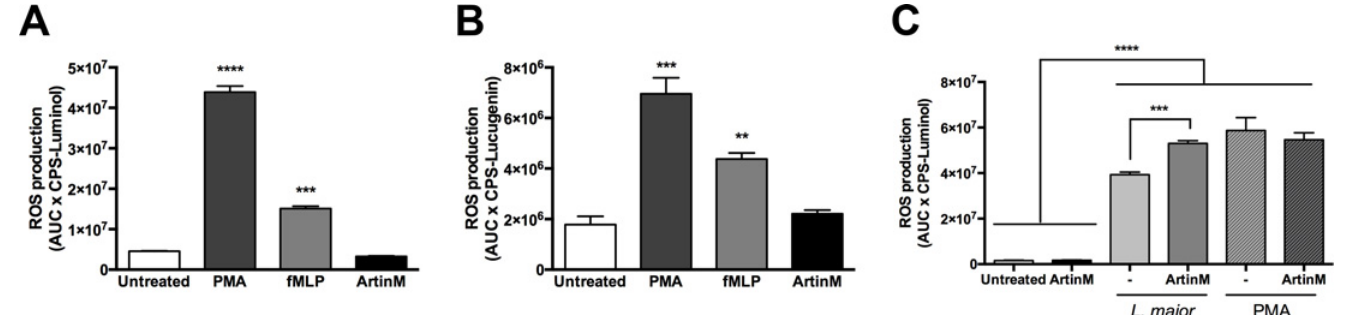
Fig 5. ArtinM augments ROS production by L . major -infected neutrophils. Human neutrophils were treated with PMA, fMLP, ArtinM or medium (untreated). ROS production was quantified by reaction with luminol ( A ) and lucigenin ( B ), producing chemiluminescent photons (CPS). Data on PMA stimulation or L . major promastigotes infected neutrophils (3:1), which were treated or not treated with ArtinM, are shown in panel C . The amounts of ROS released are expressed as mean AUCxCPS ± SD. ** p < 0.01; *** p < 0.001; **** p < 0.0001. One way ANOVA followed by Bonferroni's post-test. Each assay was carried out in triplicate. The data shown are representative of three independent